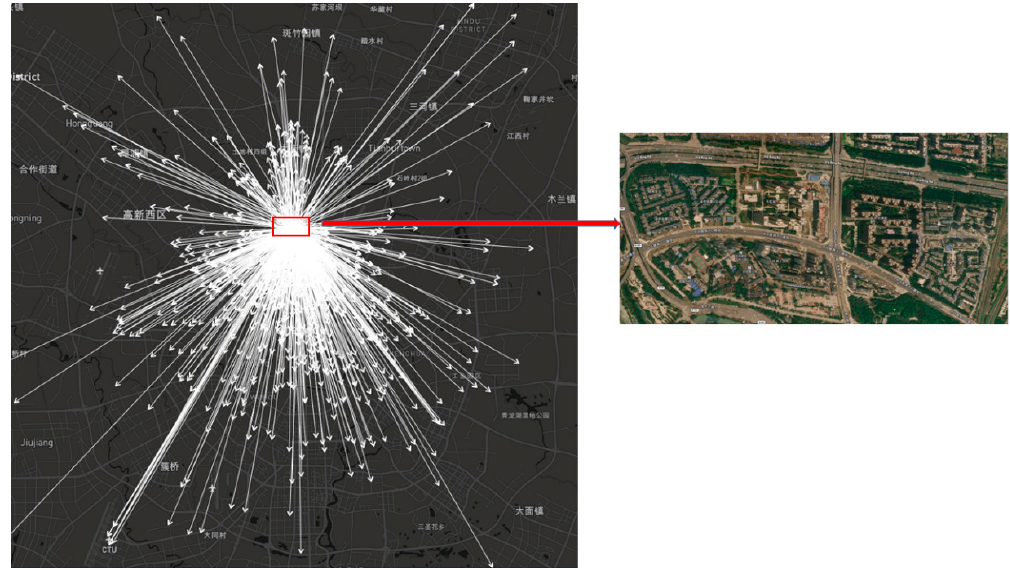
Figure 8. Illustration of the outflows of the community of Huamanting. ISPRS Int. J. Geo-Inf. 2019 , 8 , 477